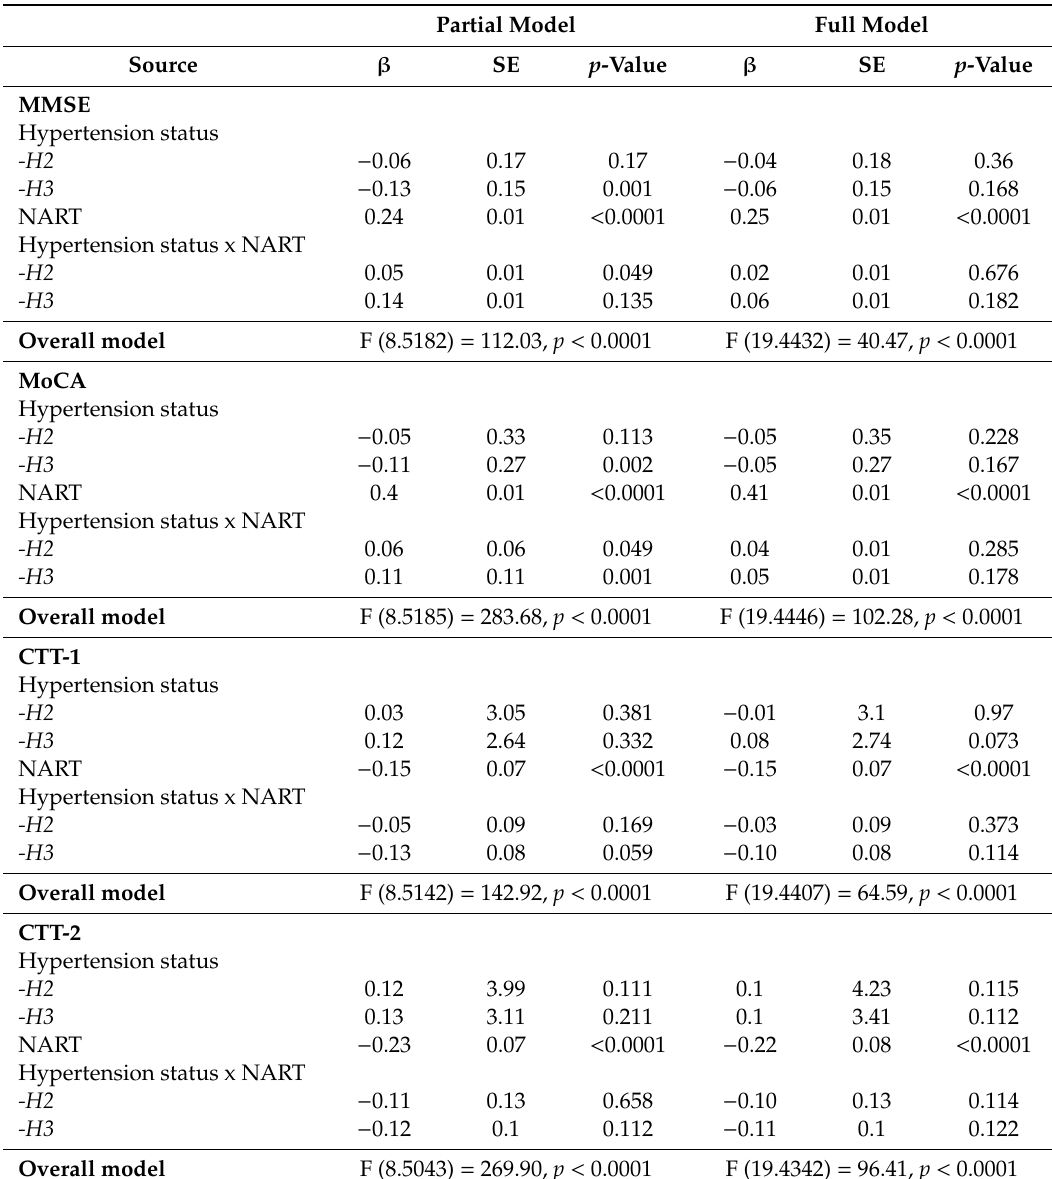
Multivariate regression results of the e ff ects of hypertension status on di ff erent cognitive